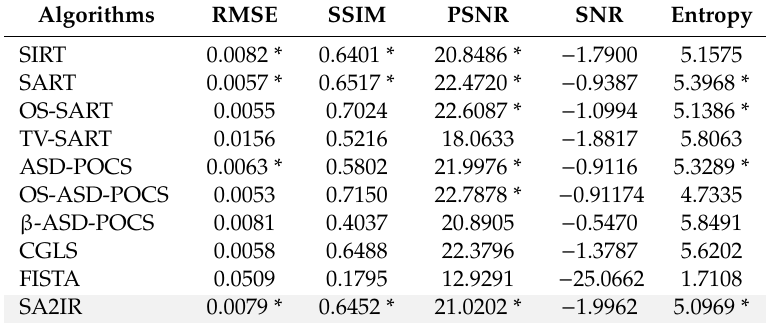
Table 4. Qualitative image quality metric evaluation of the reconstructed results in Figure 3 (from (a2) to (l2)). RMSE: root mean square error, SSIM: structural similarity, PSNR: peak signal-to-noise ratio, SNR: